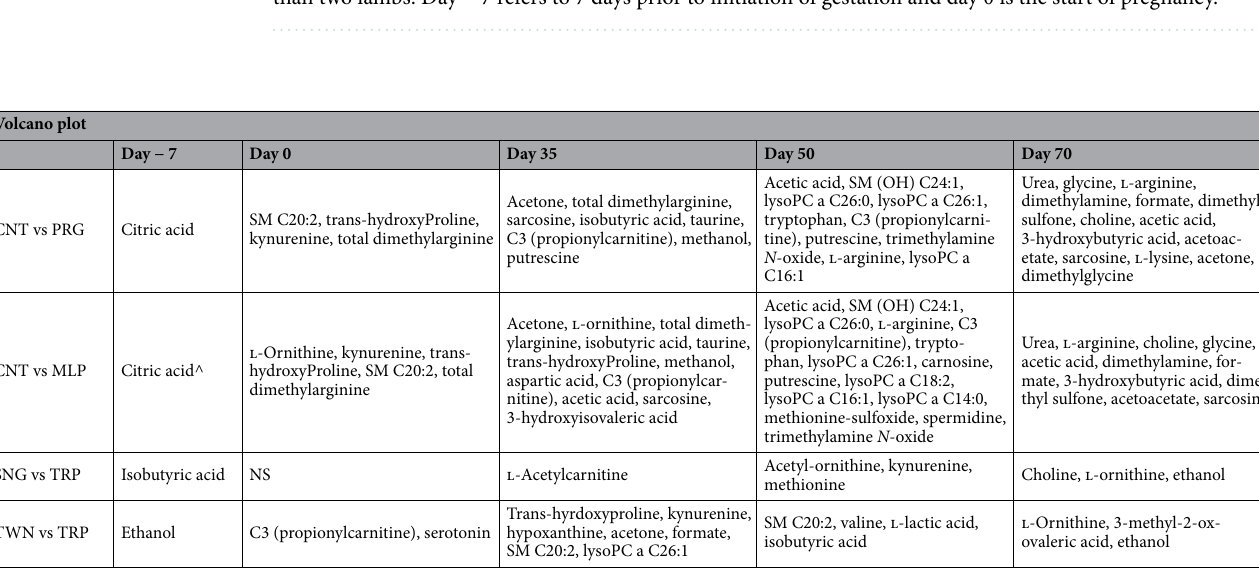
Table 3. Volcano plot univariate analysis of four comparison groups from the discovery dataset. Statistical analysis using volcano plot revealed significant (p-value < 0.05) serum metabolites of each comparison at five timepoints during the discovery phase. Metabolite noted with ^ has a tendency (p-value < 0.10). NS Not significant, CNT control open ewes, PRG pregnant ewes, SNG pregnant ewes that delivered one lamb, TWN pregnant ewes that delivered two lambs, TRP pregnant ewes that delivered more than two lambs. Day − 7 refers to 7 days prior to initiation of gestation and day 0 is the start of